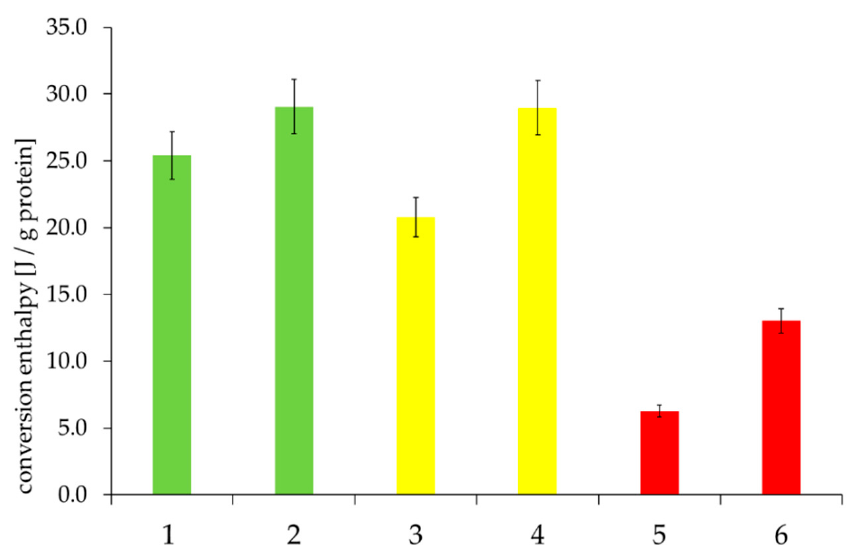
Figure 12. Conversion enthalpy in the gel phases of the selected samples, depending on “good” to “medium” to “poor” baking quality and the corresponding falling number (FN) within the individual baking quality classes (here: first samples were always assigned the lower FN and second samples the higher FN). Sample description: see Table 1. Bars represent the mean value of two replicates; error bars represent the confidence interval.